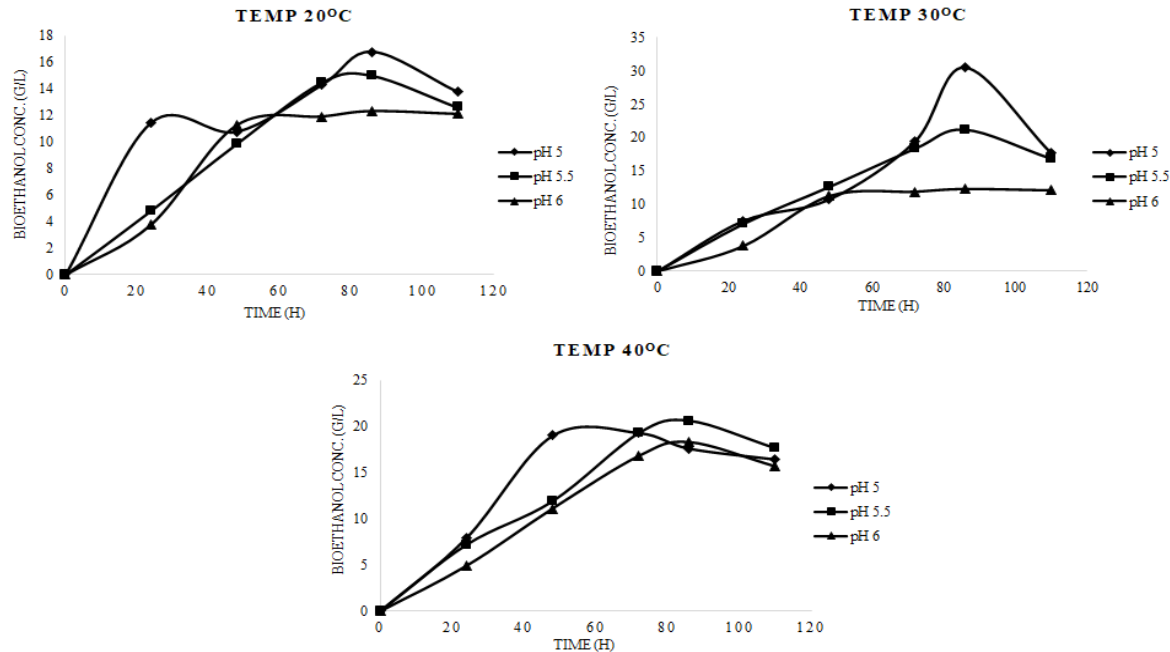
Figure 6. Effect of time, pH, and temperature on bioethanol production using S. cerevisiae .